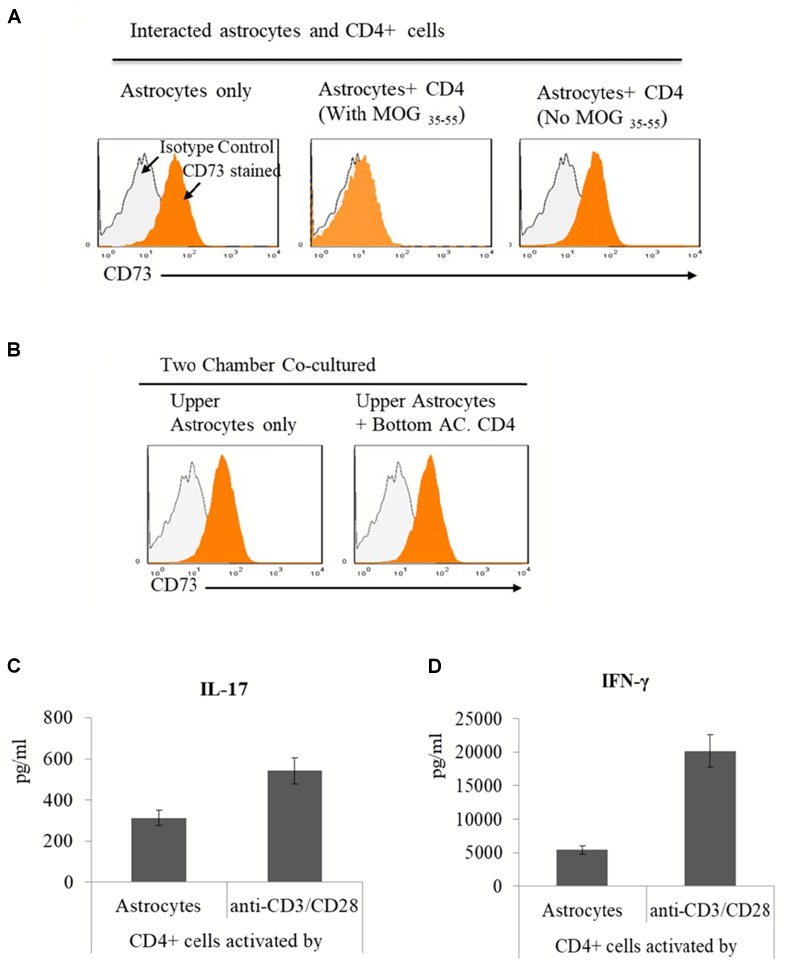
Antigen-mediated astrocyte-CD4 cell interactions account for the downregulation of CD73 in astrocytes. To study direct interactions, astrocytes were seeded in 24-well cell culture plates and pretreated with LPS (50 ng/ml) plus IFN-γ (10 ng/ml) for 1 day, pulsed with MOG35-55, and added to in vivo primed CD4+ cells. After 2 days, the CD73 density in astrocytes was analyzed by flow cytometry (A). For separated cultures, astrocytes were seeded in Transwell inserts, with or without the seeding and activation of CD4+ cells by anti-CD3 and anti-CD28 antibodies in the bottoms of the wells. CD73 expression in the astrocytes was analyzed by flow cytometry 2 days later (B). IL-17 and IFN-γ levels in the medium of the activated CD4+ cells were detected by ELISA (n = 4; C,D).